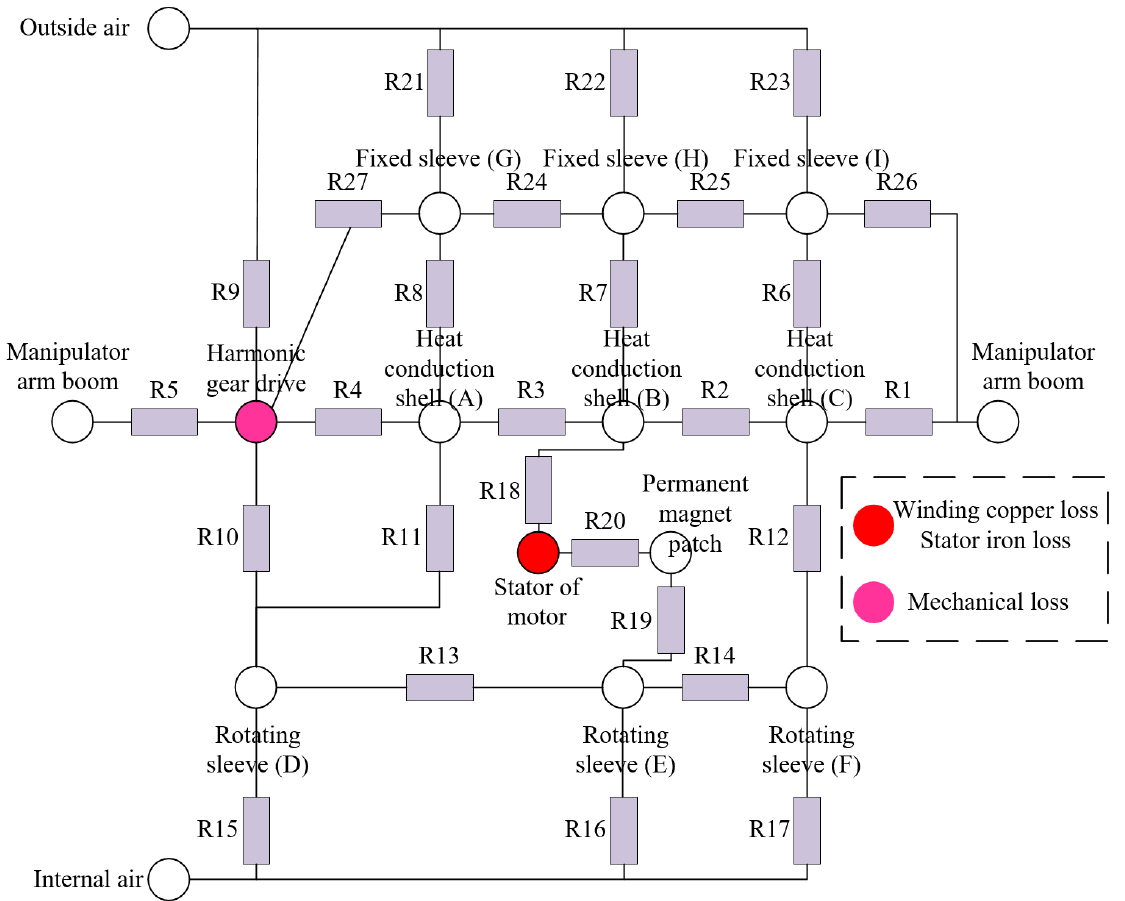
Figure 7. Thermal network model of GIERM Scheme 1.